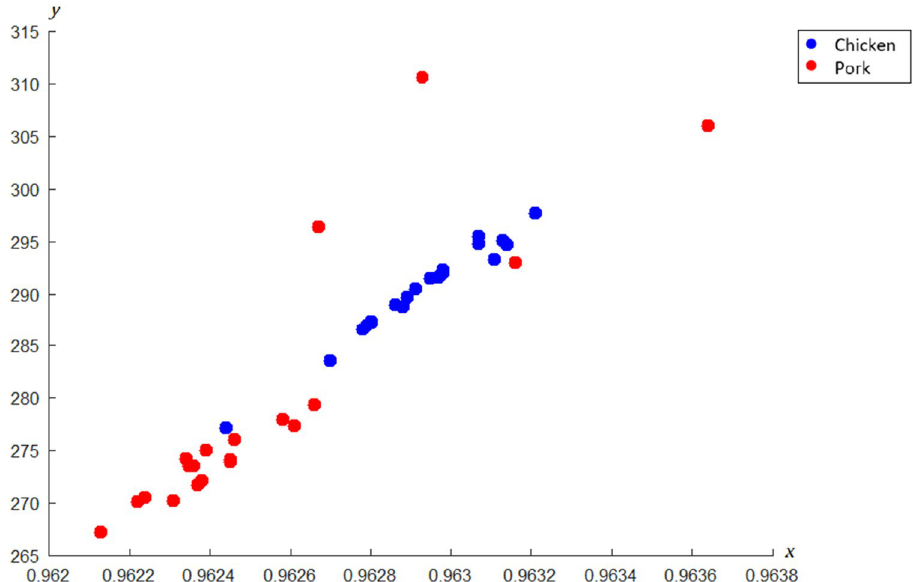
Figure 8. Coordinated c-FACS of chicken and pork